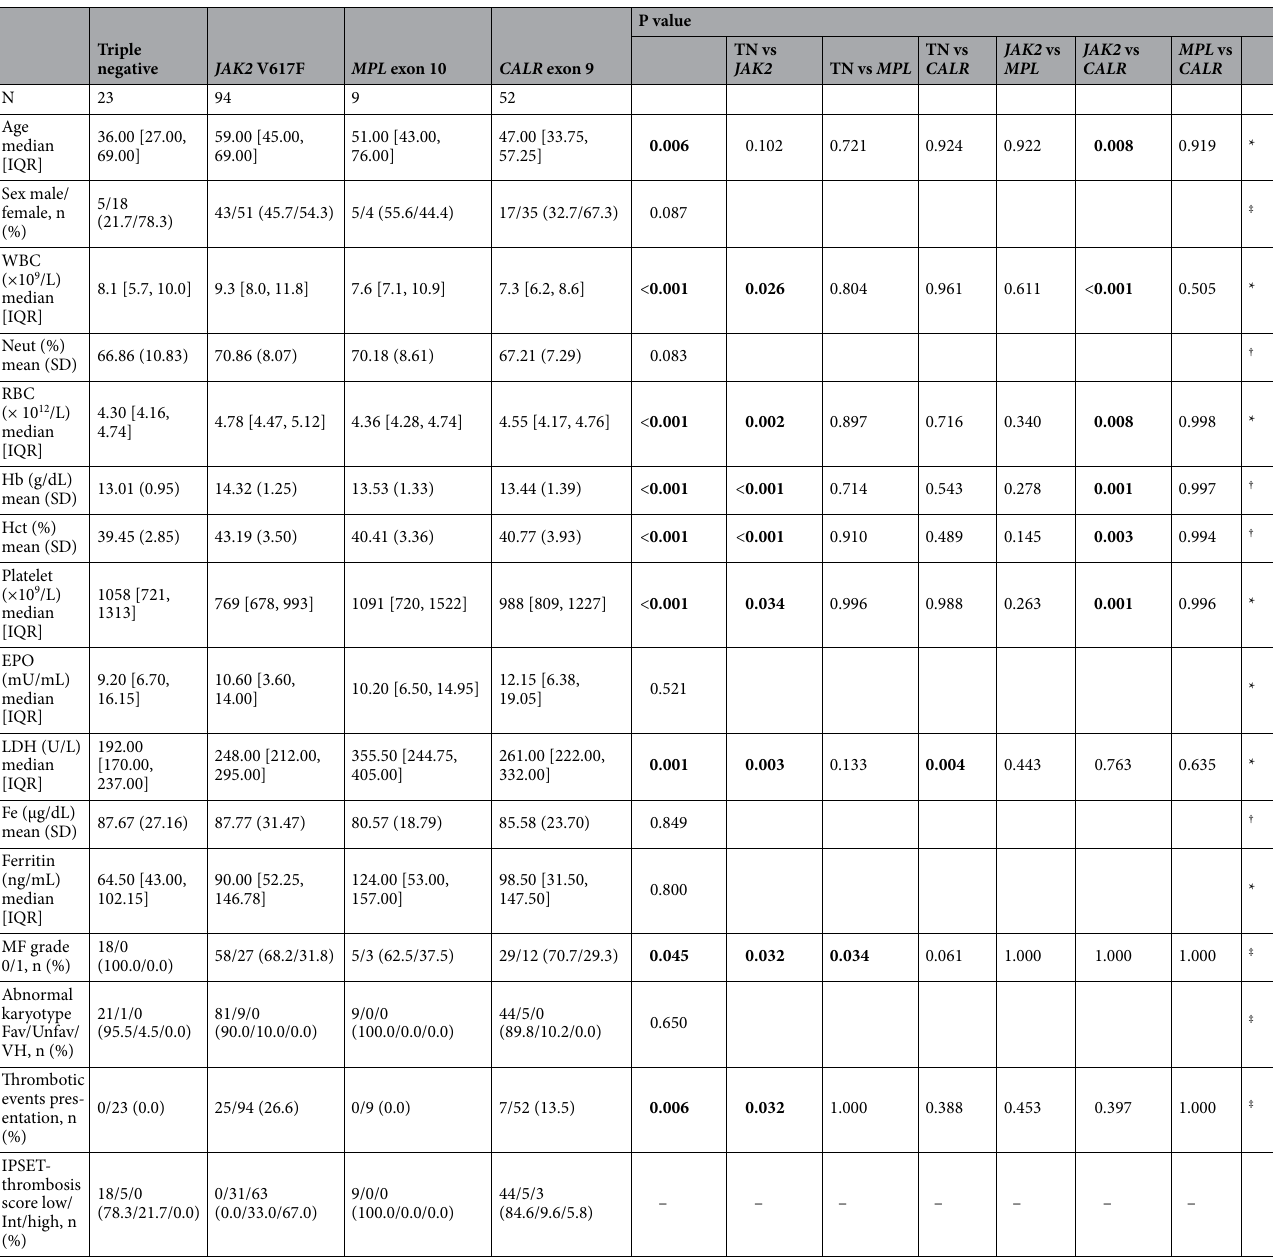
Table 1. Clinical characteristics of the ET patients grouped by driver mutation status. IQR interquartile range, Fav Favorable, Unfav Unfavorable, VH Very High, Int Intermediate. *Kruskal–Wallis test/Steel–Dwass test, † One-way ANOVA/Tukey’s HSD test, ‡Chi-square test/chi-square test with Bonferroni correction. P -values in bold indicate significance (<